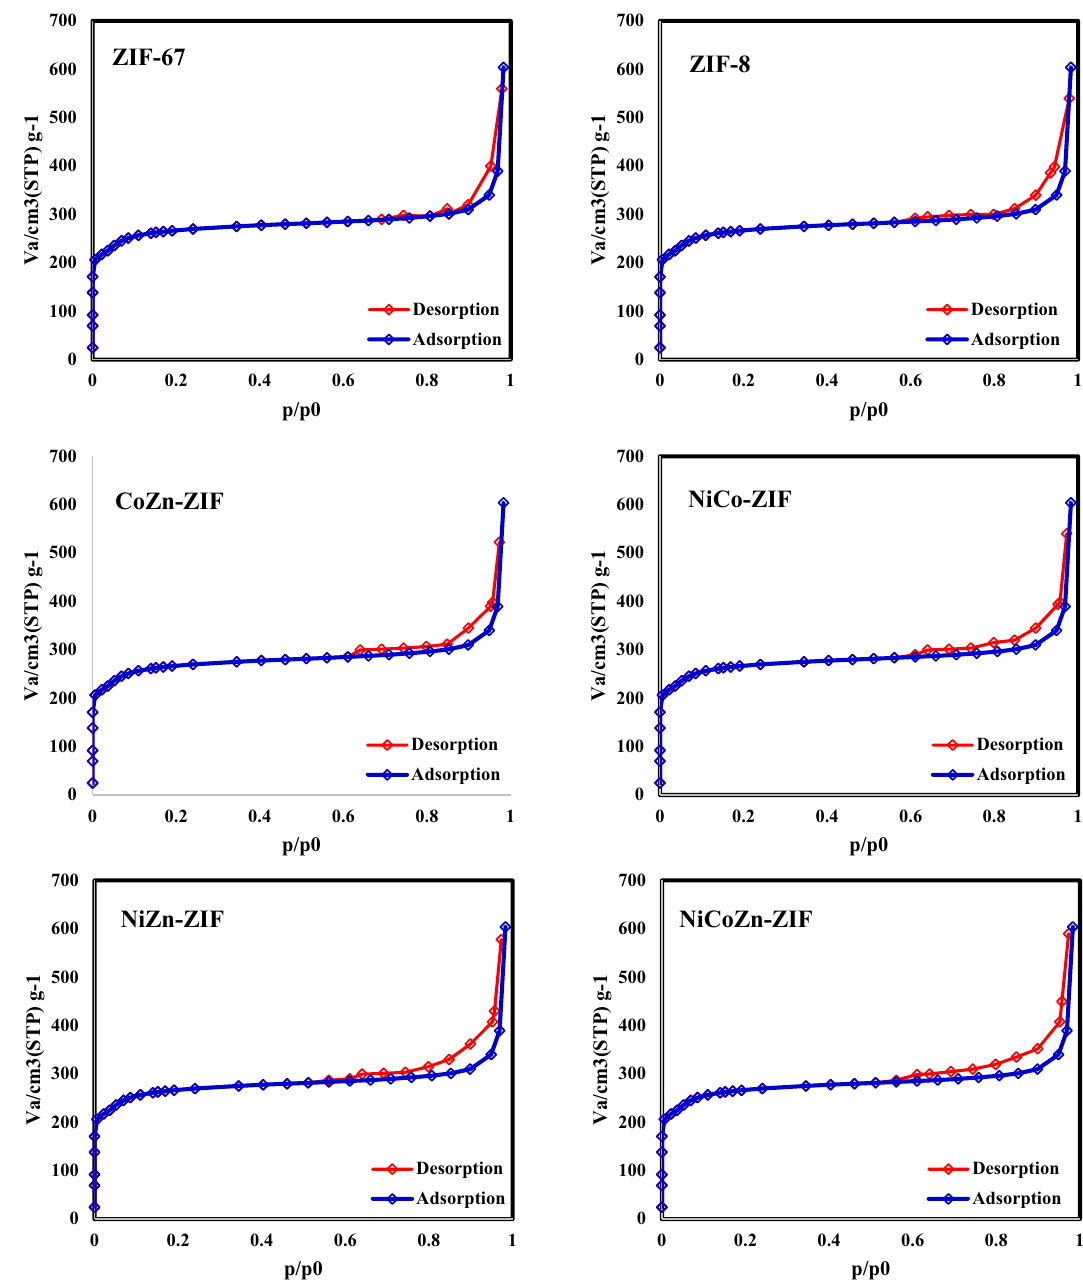
Figure 5. N 2 adsorption/desorption isotherms of ZIF-67, ZIF-8, CoZn-ZIF, NiCo-ZIF, NiZn-ZIF and NiCoZn-